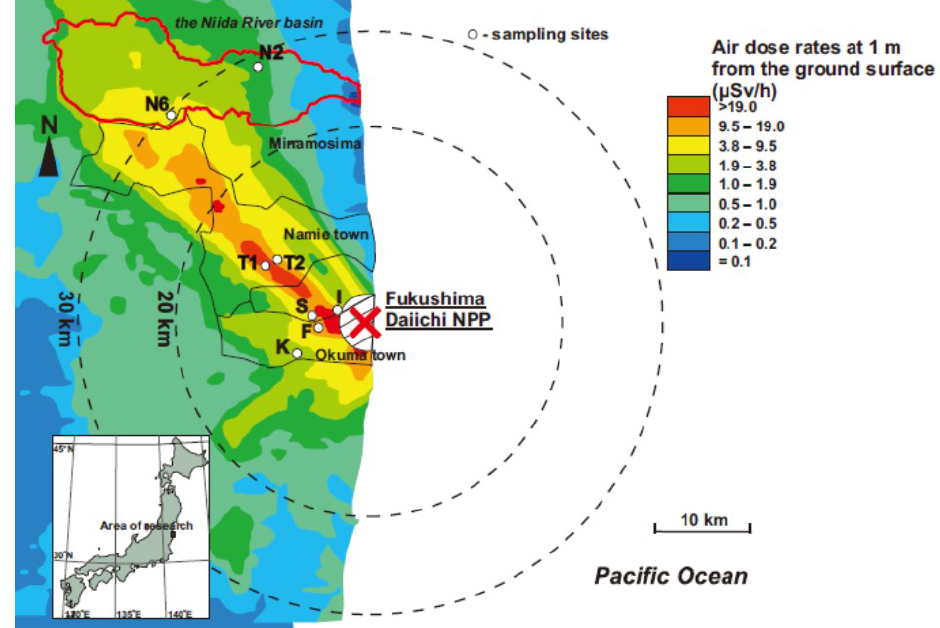
Figure 1. The map of the study area with locations of observation sites and air dose rates pattern at a distance 1m from the surface which were determined based on the results of the seventh airborne monitoring survey, 28 September 2013 (Secretariat of Nuclear Regulation Authority, 2013). Red line delineates Niida River catchment. N2 and N6 are observation sites on the Niida River catchment; T1 and T2 are observation site on Takase River catchment; I is the site on the catchment of Inkyozaka pond; S is the site on the catchment of Suzuuchi pond; F is the site on the catchment of Funasawa pond; K is the site on the catchment of Kashiramori pond.